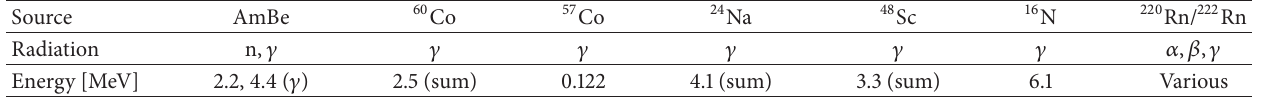
Table 1: Calibration sources that are considered for use by the SNO+